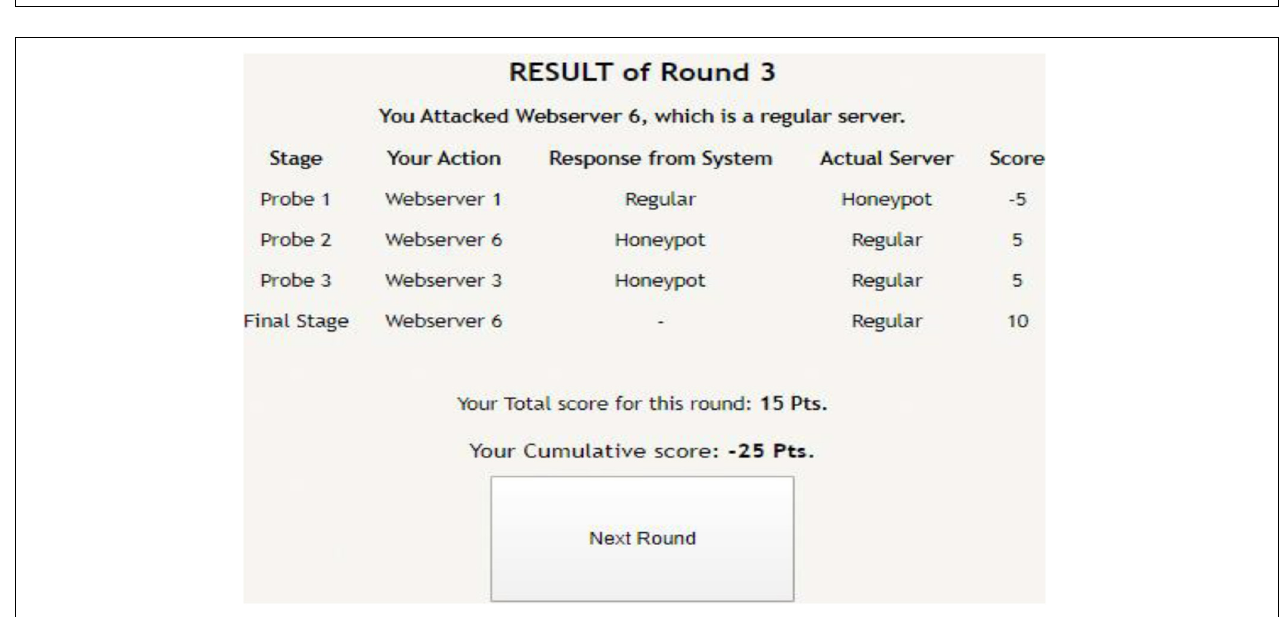
FIGURE 3 | Attack stage of the deception game with six web